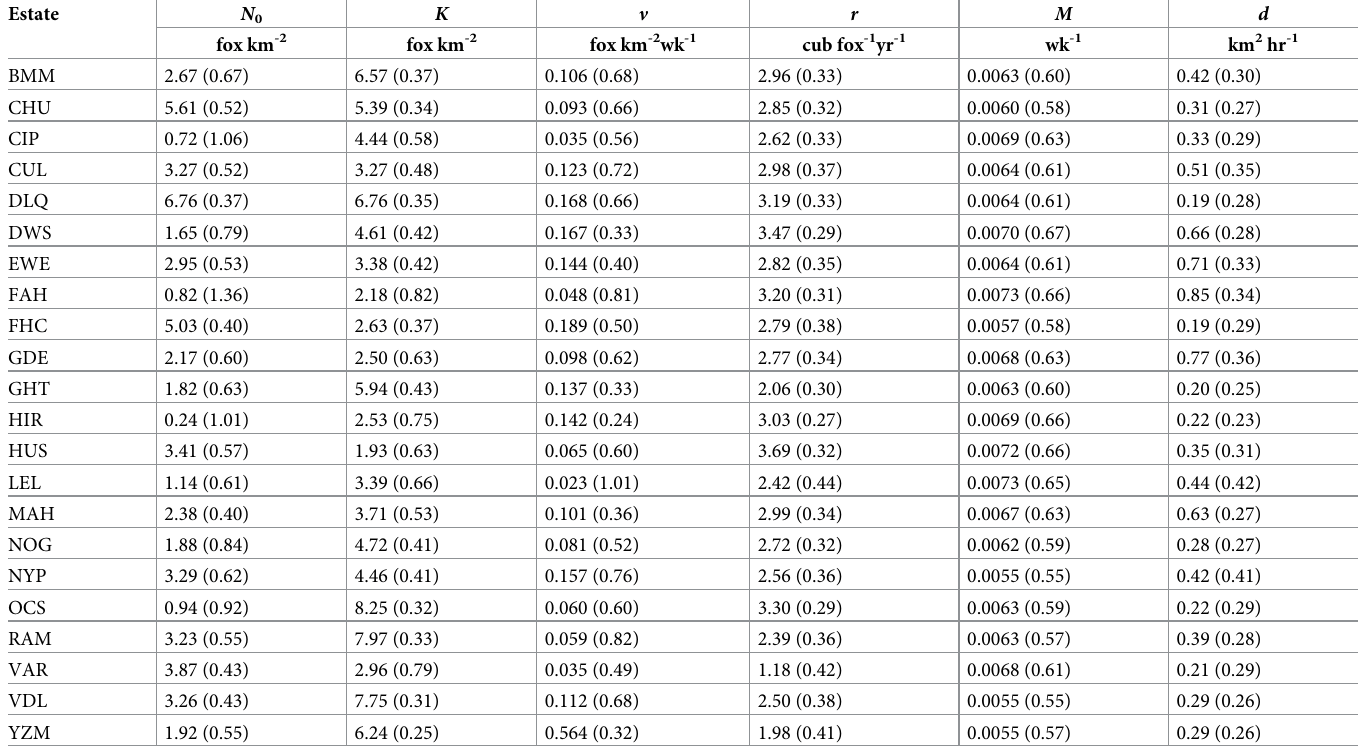
Table 3. Marginal posterior median (and CV) for estimated parameters on each estate.